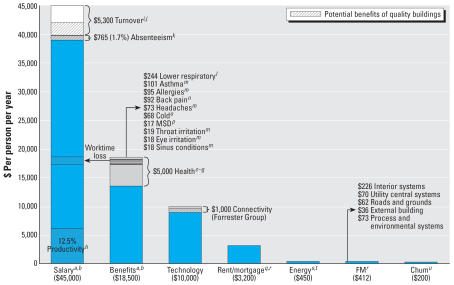
Improving the quality of the built environment will reduce the life cycle costs of business. Monetary amounts are in U.S. dollars per year. MSD, musculoskeletal disorders. Forrrester Group is part of Forrester Research (Cambridge, MA).Data from aU.S. Department of Labor (DOL) (2004a); bU.S. DOL (2004b); cU.S. DOL (2002); dKaiser Family Foundation and Health Research and Educational Trust (2003); eTowers Perrin HR Services (2003); fU.S. Chamber of Commerce (2003); gDeloitte & Touche (2003); hLeaman (2001); iU.S. DOL (2003b); jFitz-Enz (2000); kU.S. DOL (2003a); lBirnbaum et al. (2003); mU.S. EPA (1998); nGuo et al. (1999); oFendrick et al. (2003); pSilverstein et al. (2000); qGeneral Services Administration (2003); rInternational Facility Management Association (IFMA) (2002); sU.S. DOE (1998); tU.S. Department of Energy (DOE) (2004); uIFMA (2001).